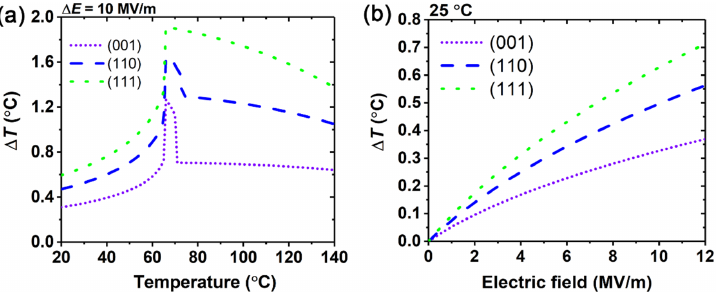
Figure 4. Comparison of electrocaloric responses in BaZr 0.15 Ti 0.85 O 3 single crystals with different orientations. ( a ) As a function of temperature under an electric field change ∆ E = 10 MV/m; ( b ) As a function of an electric field at 25 °C.